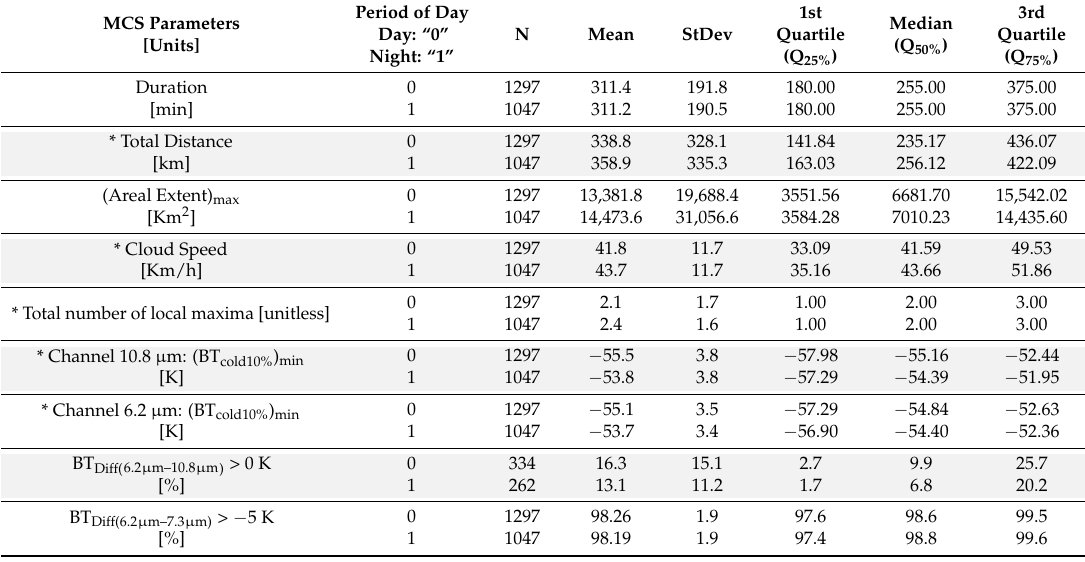
Table 5. Basic descriptive statistics for the number of MCSs with at least one CC localmax event during daytime and nighttime. The values of the parameter “BT Diff(6.2 µ m–10.8 µ m) ” refer only to the number of MCSs where at least one cloud cell during an MCS lifecycle fulfills this criterion “BT Diff(6.2 µ m–10.8 µ m) > 0 K” (596 MCS out of 2344 in total). The asterisk (“*”) represents statistically significant differences between the mean values (95% statistical confidence level).